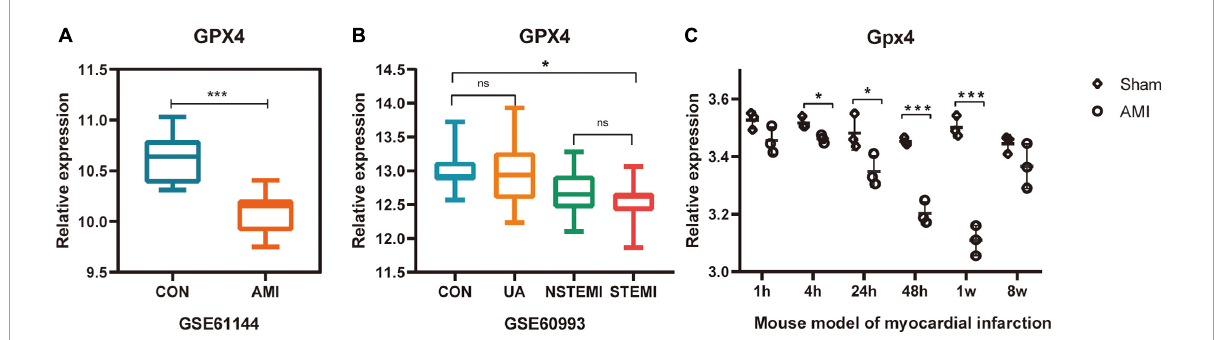
FIGURE5 Validation of the expression of ferroptosis marker GPX4 in multiple AMI related datasets. (A–C) * P < 0.05; *** P < 0.001.